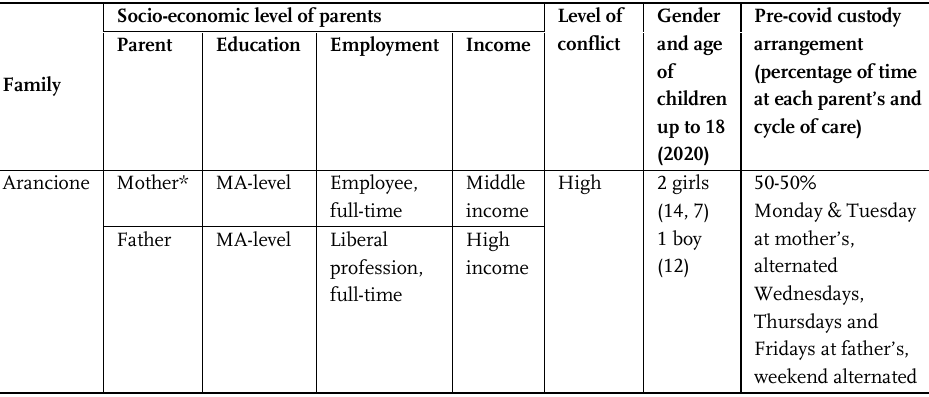
Table 1 : Family profiles and custody arrangements before Lockdown